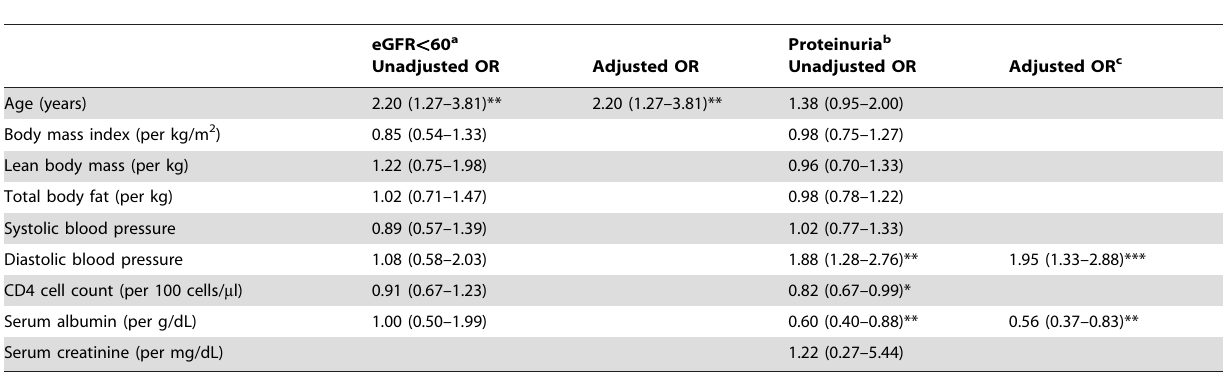
Table 4. Univariate and multivariate associations with kidney disease in HIV-infected participants.